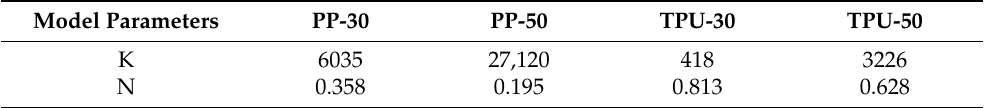
Table 3. Model parameters consistency factor K and flow exponent n from regression of viscosity curve using power approach.